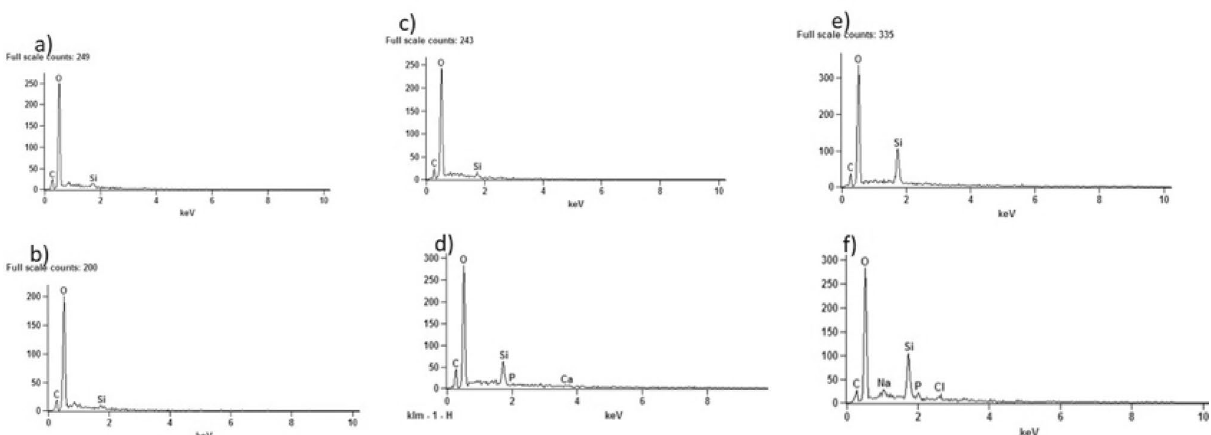
Figure 9. Evaluation of calcium (Ca) and phosphate (P) ion deposition by EDX in ( a ) G1 before immersion in simulated body fluid (SBF); ( b ) G1 after 14 days of immersion in SBF; ( c ) G2 before immersion in SBF; ( d ) G2 after 14 days of immersion in SBF; ( e ) G3 before immersion in SBF; and ( f ) G3 after 14 days of immersion in